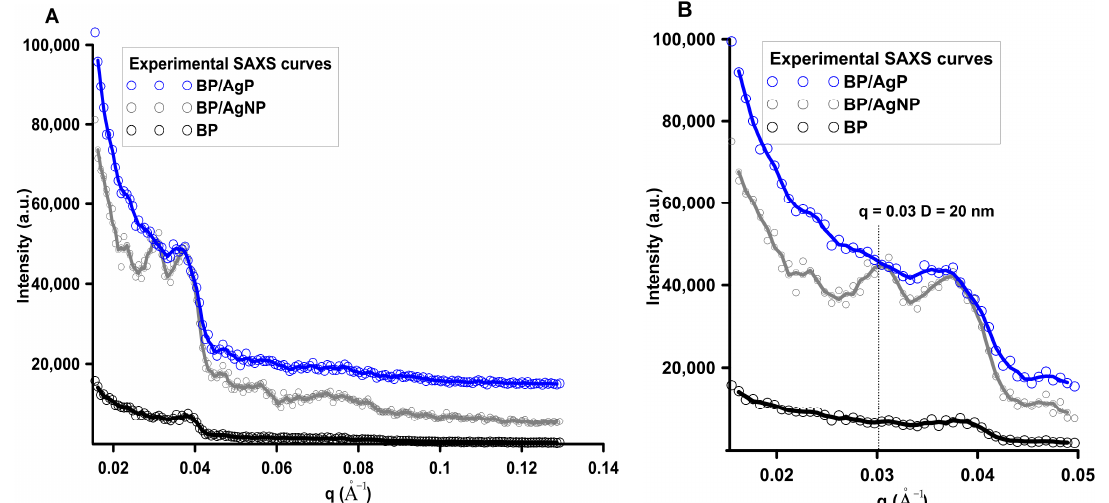
Figure 6. Experimental small-angle X-ray scattering (SAXS)profiles of BP, BP / AgP, and BP / AgNP samples in the linear ( A ) initial range of SAXS patterns in the logarithmic ( B ) scale.